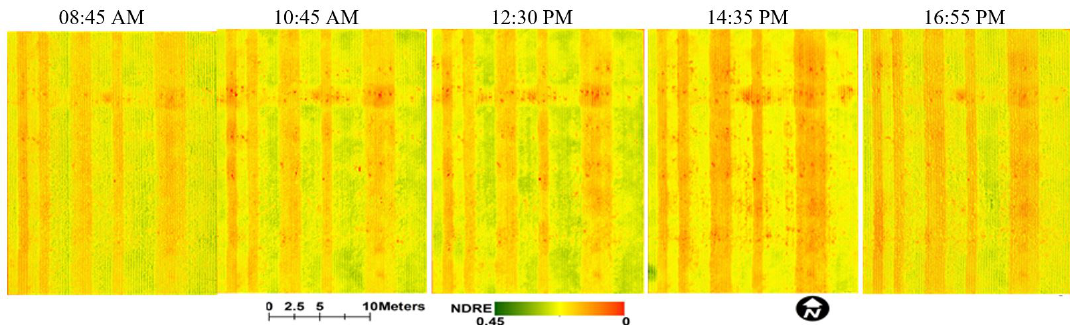
Figure 10. Visualization of spatial and diurnal change of NDVI, which indicates stress development and recovery from north to south of the field from 0.3 m rooting depth to 0.45 m, 0.6 m, and 0.75 m rooting depths divergence